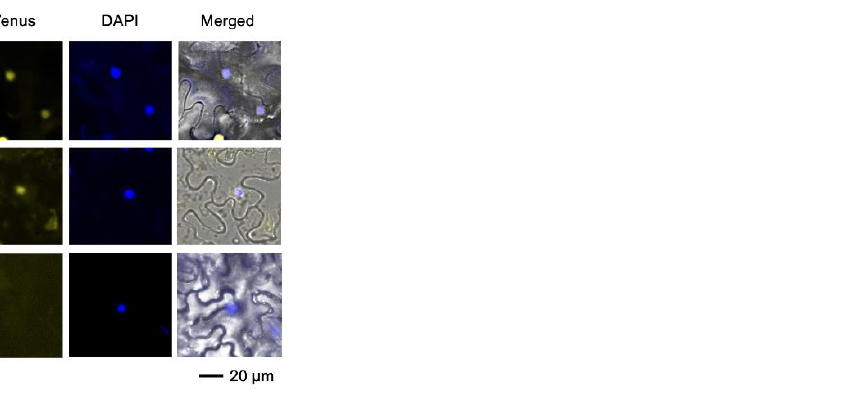
Figure 5. Bimolecular fluorescence complementation analysis of in planta interaction of JUL1, JAV1 or JAZ8 fused to the N-terminal fragment of Venus with ERF15 fused to the C-terminal fragment of Venus in Nicotiana benthamiana leaf cells. The photographs with reconstructed Venus signal, DAPI (4′,6 -diamidino-2-phenylindole) fluorescence, and the merged image with bright field are shown.